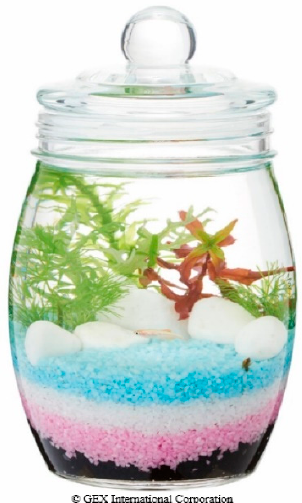
Figure 1. An Example of a Bottleium. One fish and one water snail are allowed in each bottle. An aeration and filtering system is not required.